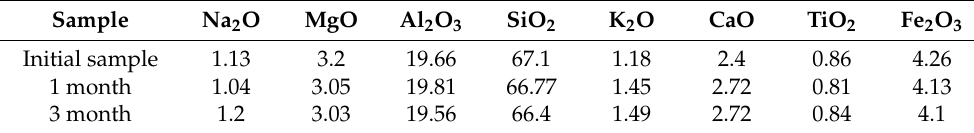
Table 5. Chemical composition of rock-forming elements (wt%).